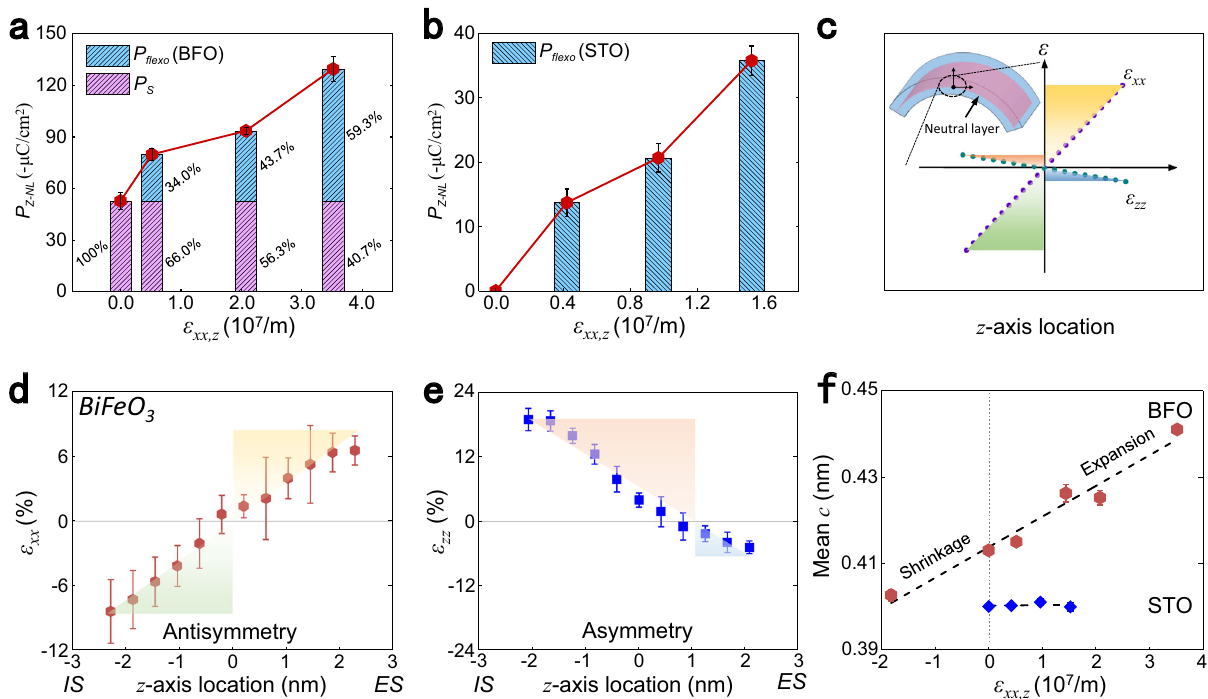
d Antisymmetric in-plane and ( e ) asymmetric out-of-plane strain distributions in the bent BFO with a strain gradient of 3.5×10 7 m − 1 along the thickness direction. Error bar represents the standard deviation of measured unit-cells. f Mean lattice spacing c as a function of the strain gradient in the bent BFO and STO. Error bar represents the standard deviation of measurement in each